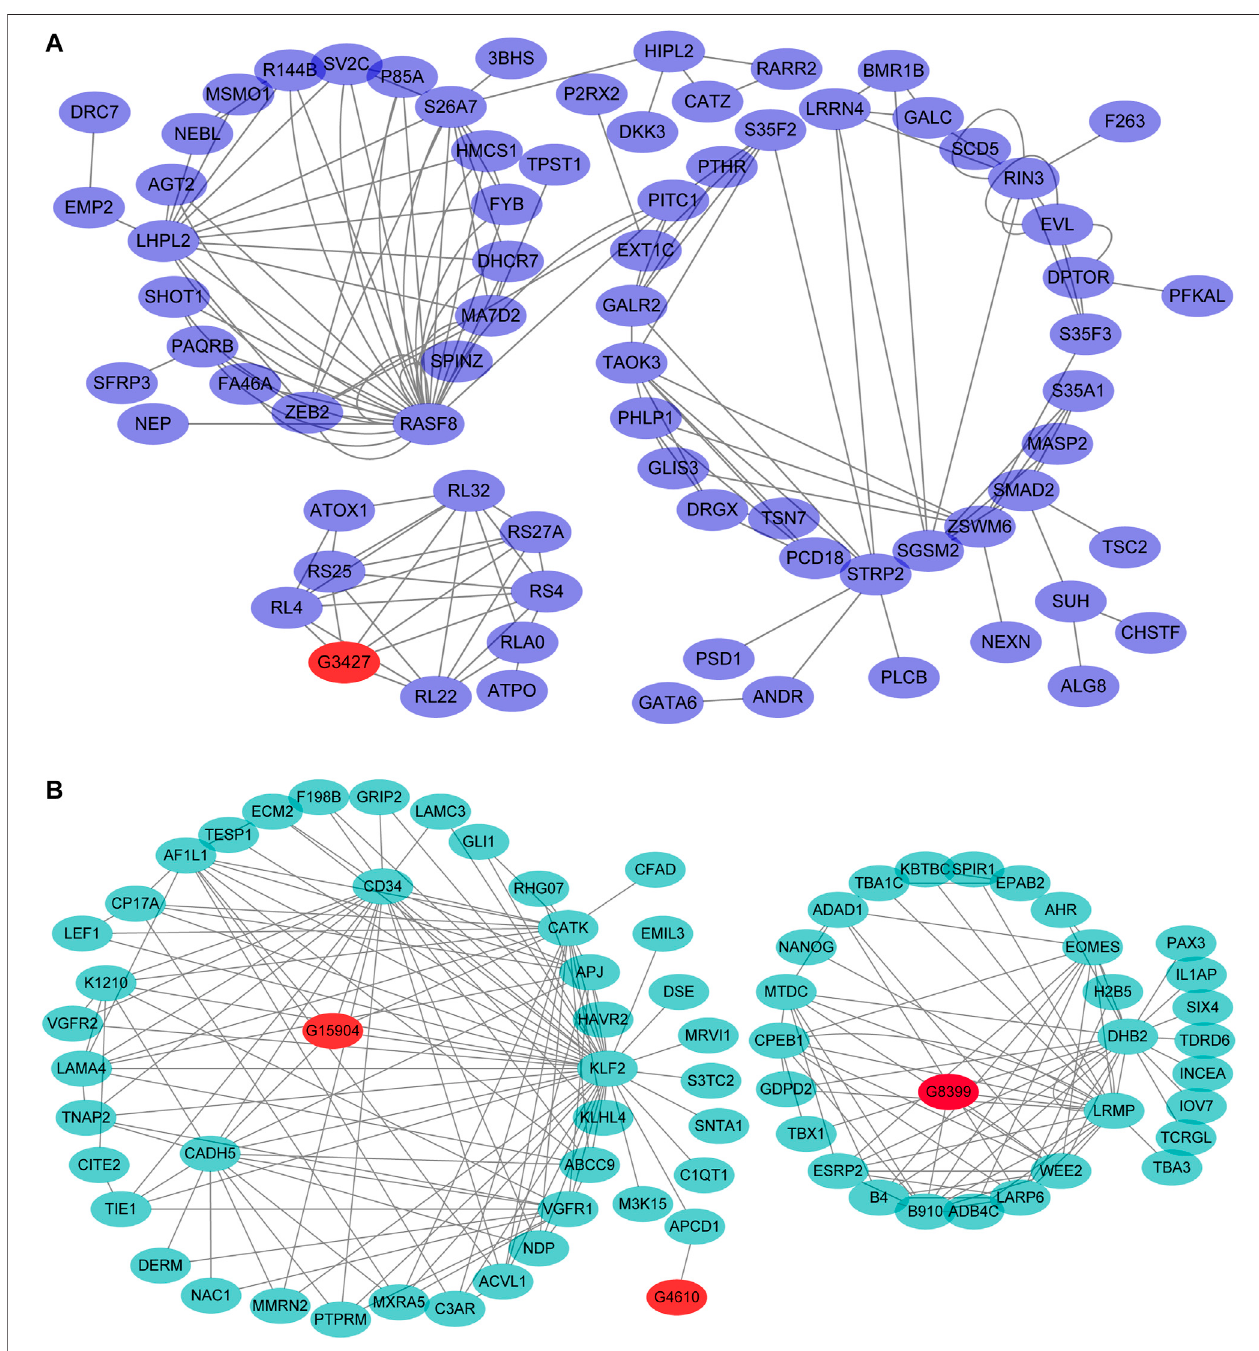
FIGURE 6 | The cis -and trans -target genes were predicted and the mRNA-lncRNA network in cluster 2 and 3. Note: (A) , The mRNA-lncRNA network in cluster 2; (B) , The mRNA-lncRNA network in cluster 3.